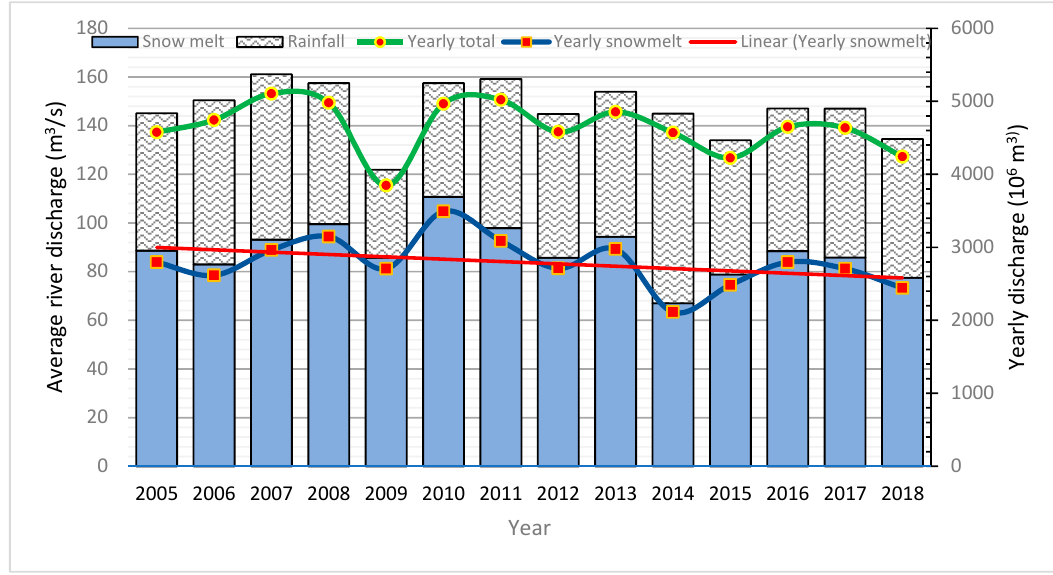
Figure 10. Snowmelt contribution in Budhi Gandaki River discharge.